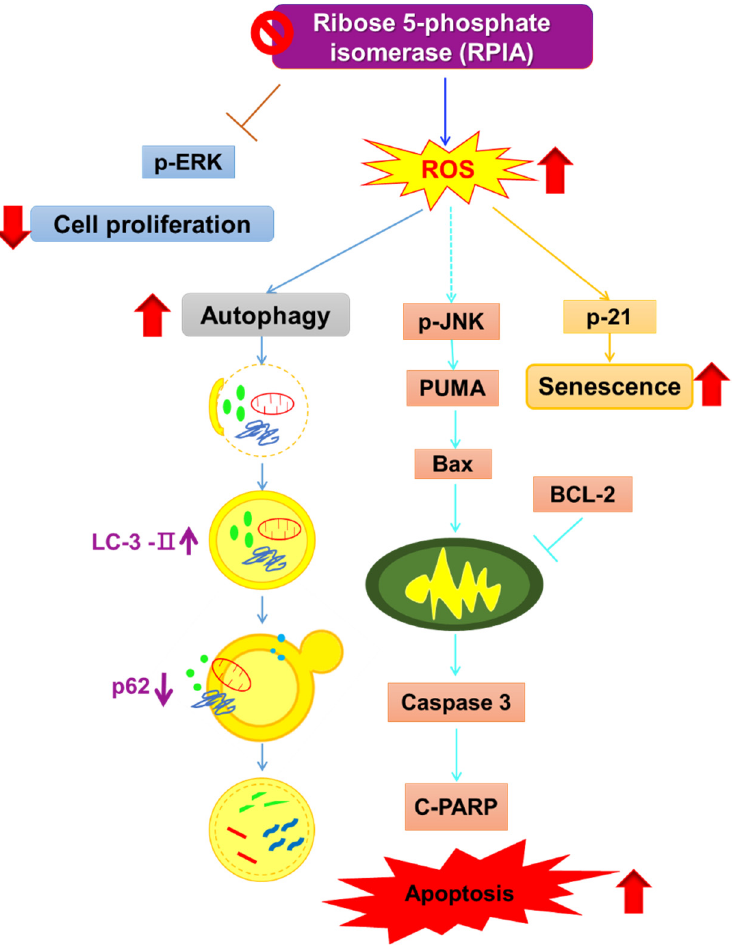
Figure 9. The working model for the molecular mechanisms of RPIA suppression activates apopto- sis, autophagy and cellular senescence. The RPIA knockdown-induced autophagy is cytoprotective and a resistant mechanism against apoptosis. a resistant mechanism against